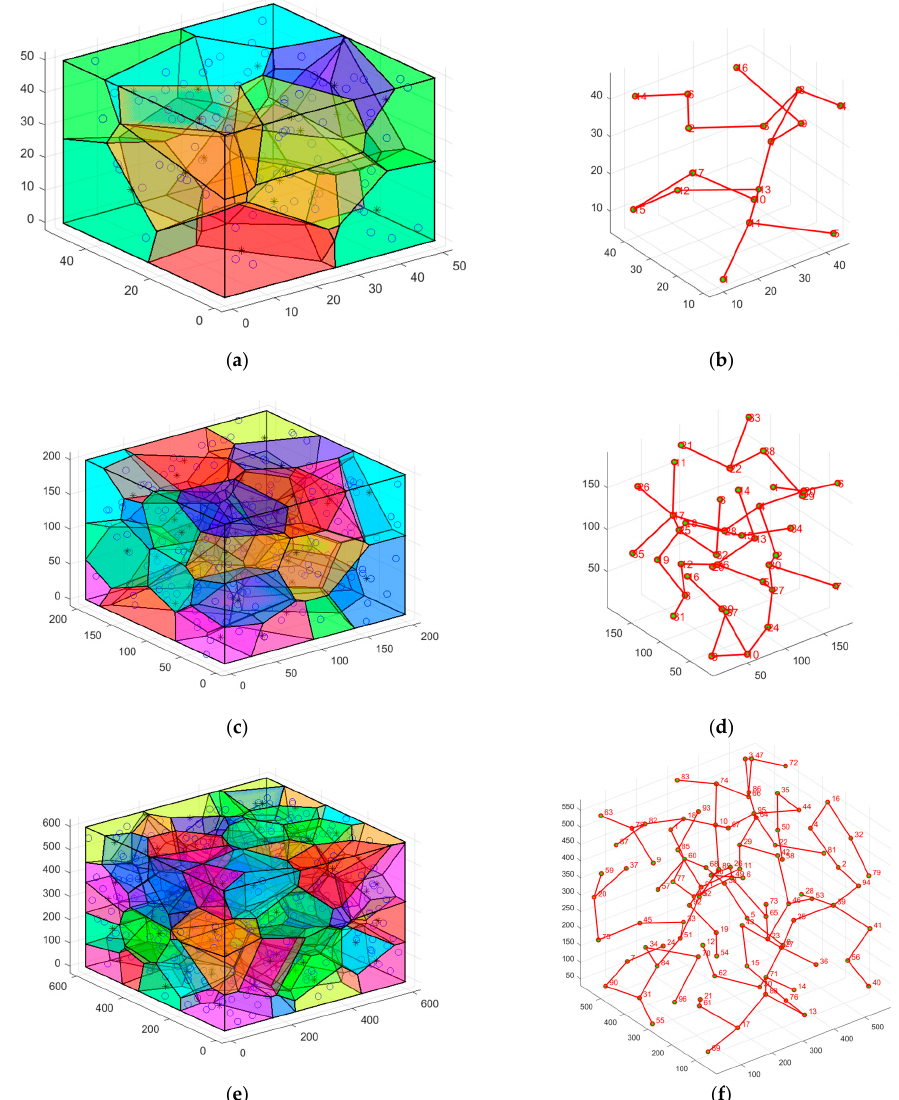
Figure 10. 3D-Voronoi partition results and minimal spanning tree: ( a ) The small networks: 3D-Voronoi partition results and center of mass; ( b ) The small networks: minimal spanning tree; ( c ) The medium-sized networks: 3D-Voronoi partition results and center of mass; ( d ) The medium-sized networks: minimal spanning tree; ( e ) The large networks: 3D-Voronoi partition results and center of mass; ( f ) The large networks: minimal spanning tree.